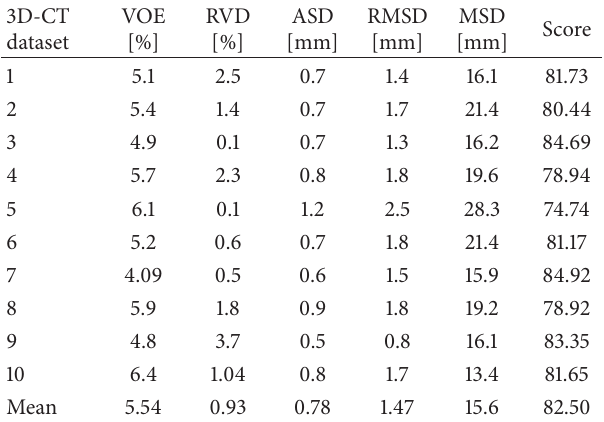
Table 3: Evaluation on IRCAD dataset.